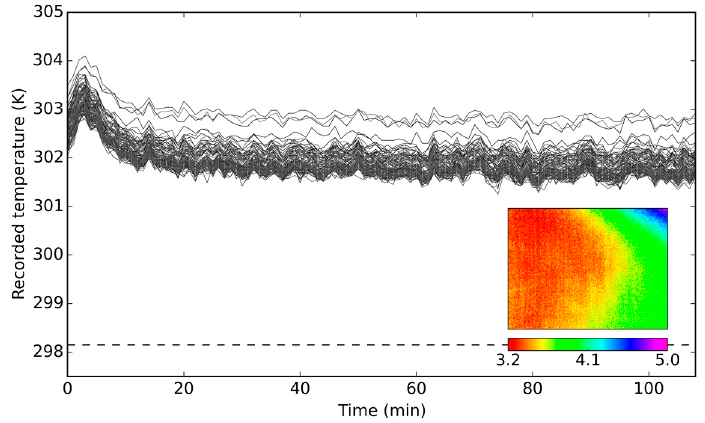
Figure 4. Temperature readings over time of a blackbody at 298.15 K (dashed line), as recorded by 100 randomly chosen pixels, alongside recorded image offsets from the blackbody temperature (given in K) at Minute 80. The temperature readings were adjusted for the blackbody’s emissivity value ( ε BB = 0.96). The initial spike in values (first 30 min) was due to the camera warming up period. The derived non-uniformity correction accounted for the overestimation in the average temperature readings (Figure 5); the imagery was representing the actual blackbody temperature with maximum offsets of mean image temperature of 0.23 K. The variation in temperature readings across the imagery had also been minimized, with 95.4% (2 σ ) of the pixels falling within ±0.14 K (average across the time series) of the mean temperature reading. The resultant gain and offset